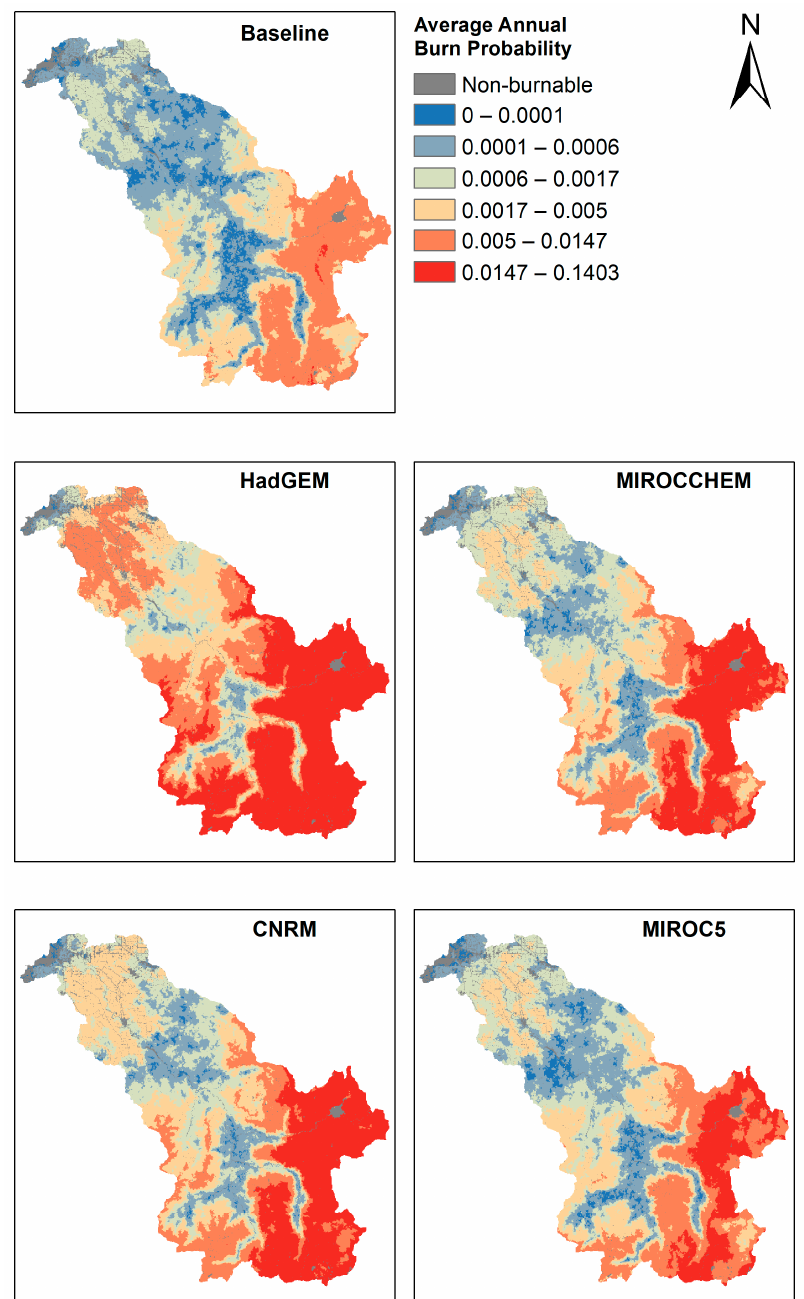
3 Figure 8. Average annual burn probability in the Clackamas Basin under baseline (1992–2015) and four mid-century (2040–2069) scenarios. HadGEM is the warmest and driest future scenario, followed by CNRM. Both MIROCCHEM and MIROC5 project small increases in summer relative humidity and are less hot than HadGEM and CNRM but are still warmer than baseline conditions. Non-burnable pixels indicate water, rock / ice, high density urban areas, and agriculture. Results are classified using a quantile